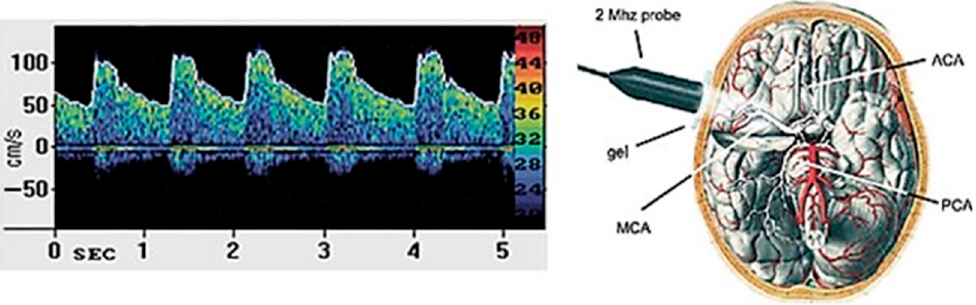
Figure 1. Schematic illustration of a standard TCD exam and main insonated arteries. ACA: anterior cerebral artery; MCA: middle cerebral artery; PCA: posterior cerebral artery.